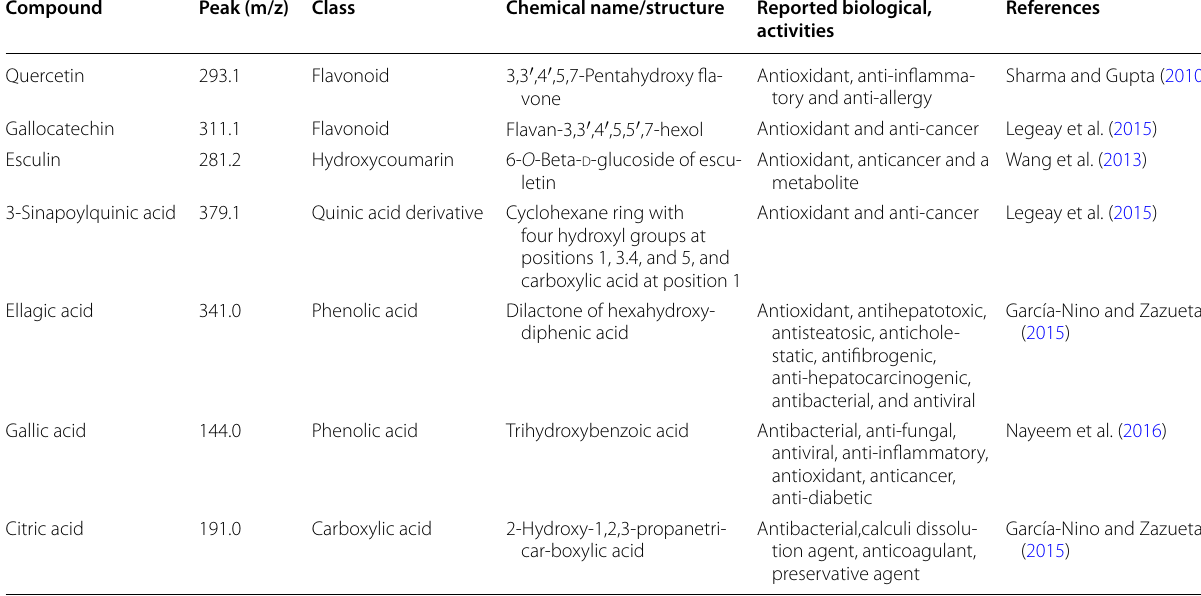
Table 2 Compounds identified by mass spectroscopy and their properties Compound